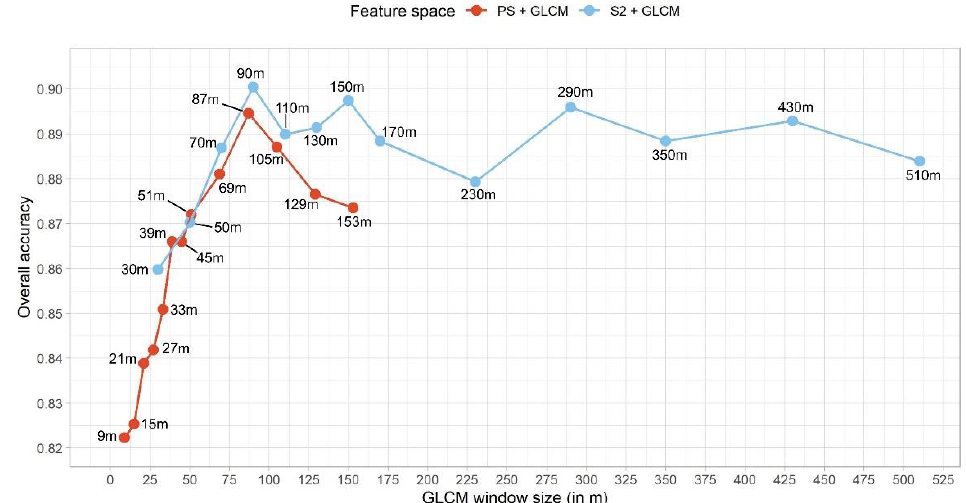
Figure 4. Overall accuracies of mountain pine classifications based on PS and S2 (Table 1) feature spaces combined with different GLCM window sizes (in meter). GLCM window sizes were calculated from 3 × 3, 5 × 5, 7 × 7, 9 × 9, 11 × 11, 13 × 13, 15 × 15, 17 × 17, 23 × 23, 29 × 29, 35 × 35, 43 × 43 and 51 × 51 pixels for both PlanetScope and Sentinel-2 data (Section 2.3.1.).